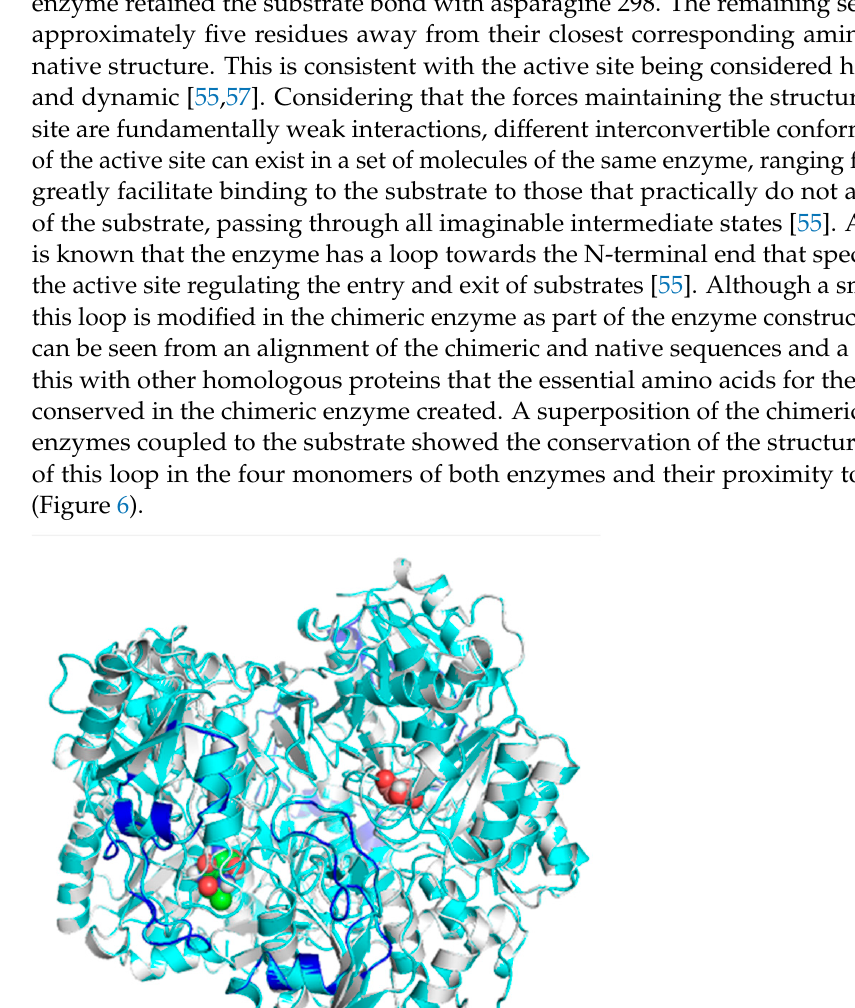
the differential substrate